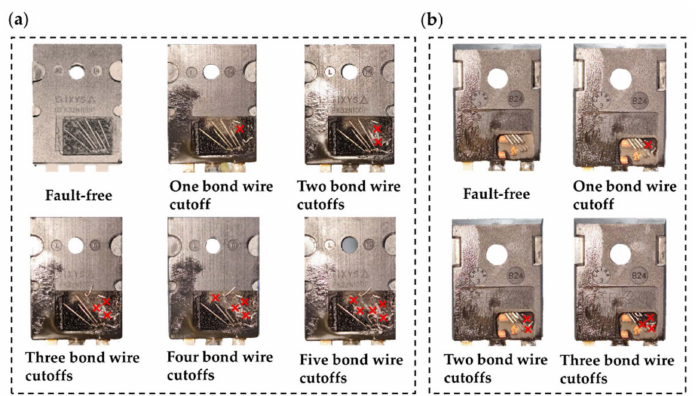
Figure 9. Bond wire damage models. ( a ) TO − 247 Si MOSFET (its source has six aluminum bond wires connected in parallel). ( b ) TO − 247 SiC MOSFET (its source has four aluminum bond wires connected in